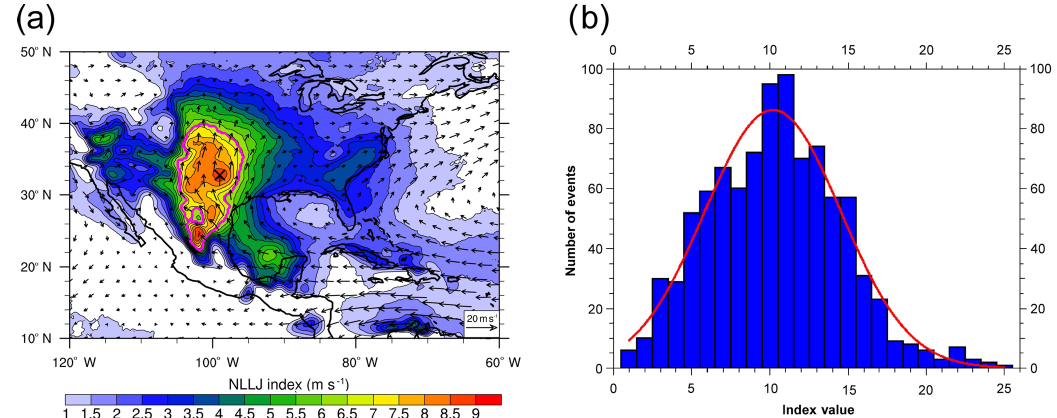
Figure 1. (a) Mean NLLJ index (shaded) and 500m winds (arrows, in ms − 1 ) at local midnight in July (boreal summer) for 1980–2016, calculated from ERA-Interim reanalysis. The black cross at 32.75 ◦ N, 99 ◦ W shows the point of maximum NLLJ in the climatology. The magenta contour line surrounds the region containing points above the 75th percentile. (b) Frequency distributions of the GPLLJ for the months of July from 1980 to 2016 (blue bars). The red curve corresponds to the Gaussian fit (see Table A2). Note: the frequency distributions are calculated at the point of maximum intensity of the NLLJ (at 32.75 ◦ N, 99 ◦ W; black cross in a ).